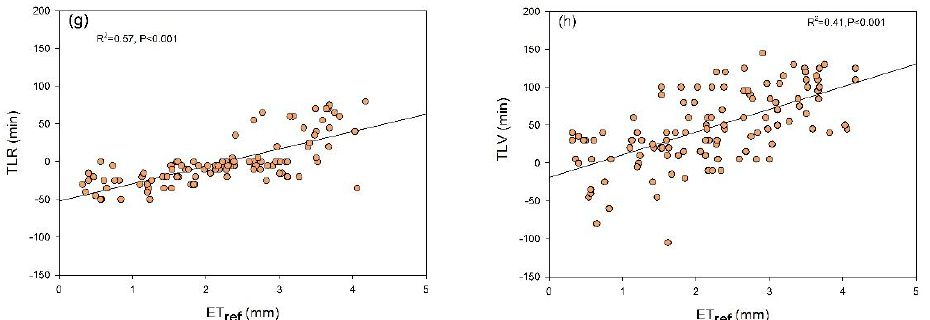
Figure 6. TLR (time lag between sap flux density and solar radiation) and TLV (time lag between sap flux density and vapor pressure deficit) responses to different environmental factors, namely, solar radiation (R s ), vapor pressure deficit (VPD), relative extractable water (REW) and reference crop evapotranspiration (ET ref ): ( a ) Linear regression between VPD-normalized TLR and R s ; ( b ) linear regression between VPD-normalized TLV and R s ; ( c ) linear regression between Rs-normalized TLR and VPD ; ( d ) linear regression between Rs-normalized TLV and VPD; ( e ) relationship between TLR and REW; ( f ) relationship between TLV and REW; ( g ) linear regression between TLR and ET ref ; ( h ) linear regression between TLV and ET ref . To eliminate confounding effects in VPD and Rs, we normalized the time lag by meteorological factors in the relationships between time lag and these two parameters. Positive time lag values represent J s (sap flux density) peaks preceding peaks in meteorological drivers; negative time lag values represent J s peaks lagging behind peaks in meteorological drivers. R 2 refers to the determination coefficient. Table 2. Regressions between time lag (TLR refers to the time lag between solar radiation and sap flux density; TLV refers to the time lag between vapor pressure deficit and sap flux density) and ET ref (reference crop evapotranspiration) and REW (relative extractable water) in different REW categories: REW < 0.38 and REW > 0.38. R 2 refers to the determination coefficient.